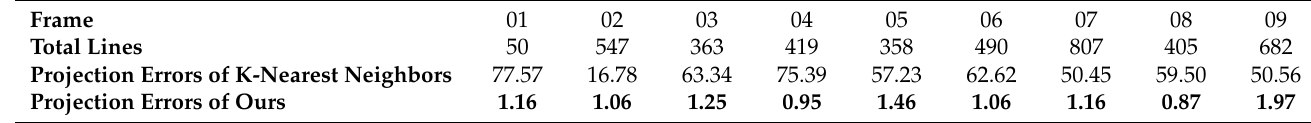
Table 1. Outlier removal experiments of line segments.